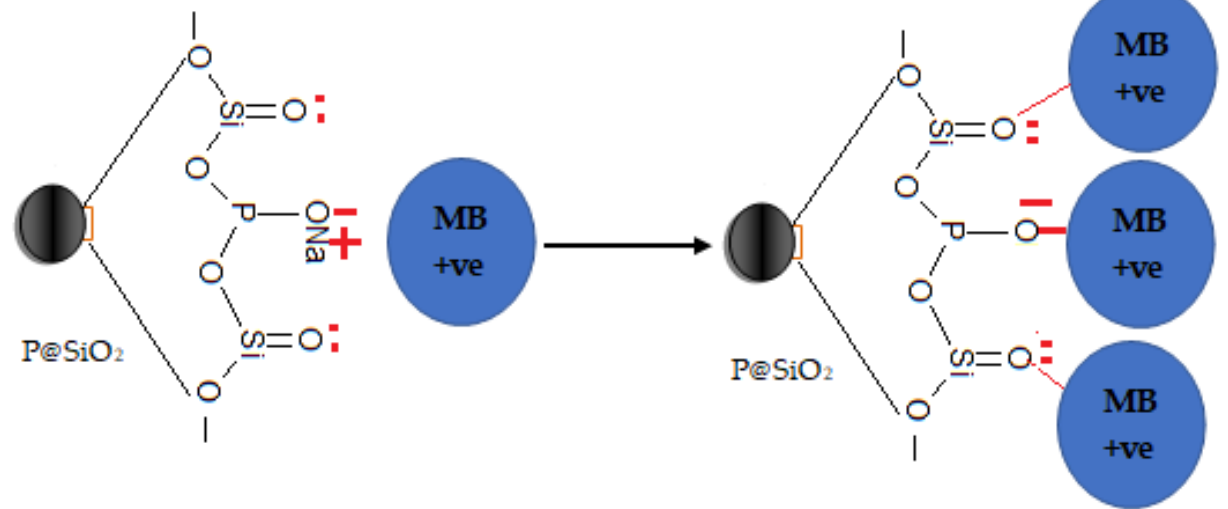
Figure 8. The proposed adsorption mechanism of MB dye onto P@SiO 2 nanocomposite from aque- ous media.